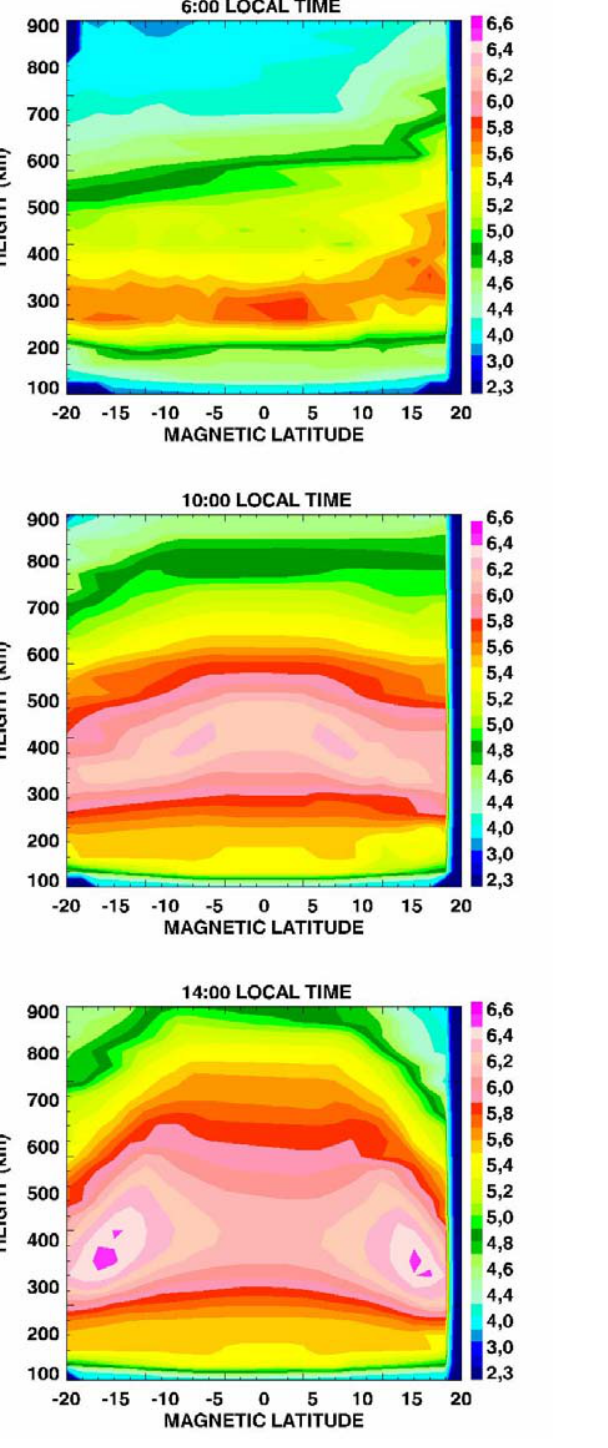
Fig. 3. Ionospheric electron density distribution as a function of height and magnetic latitude for various local times generated by the LION model for average solar conditions in the Brazilian longitudinal region, during